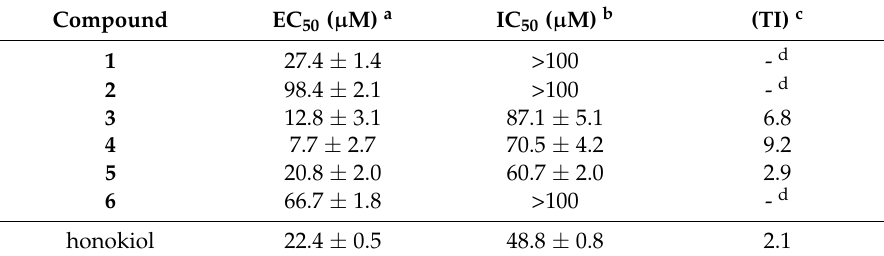
Table 2. Anti-HCV activities (EC 50 ) and cytotoxicity (IC 50 ) of 1 – 6 .